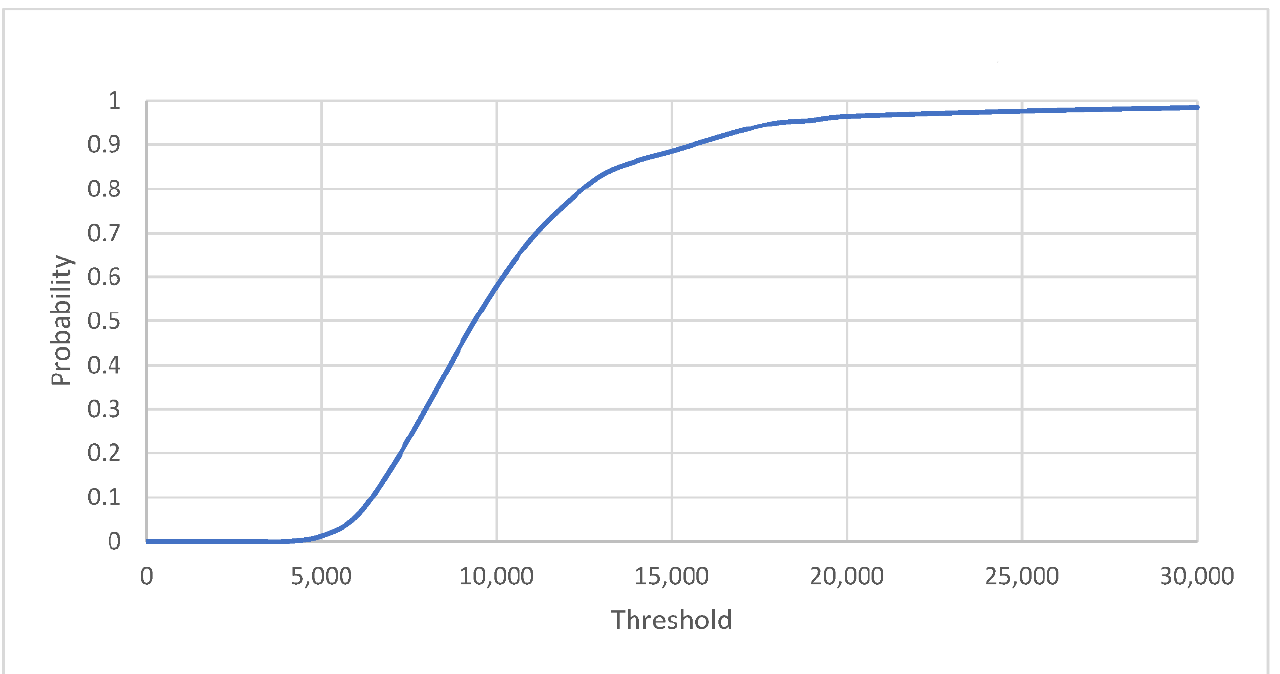
Figure 1. Cost acceptability curve for thresholds up to €